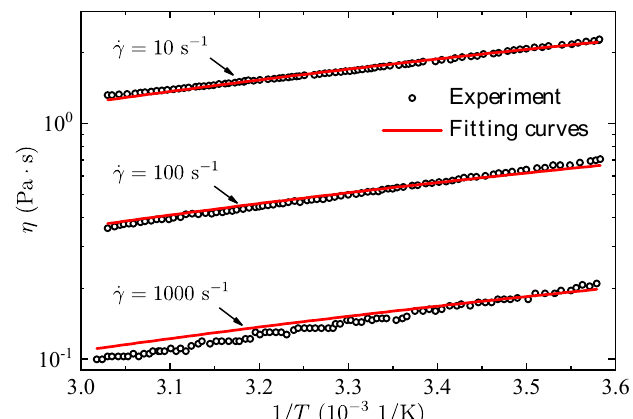
Figure 1. Experimental measurements and the model prediction of the viscosity of the water-gel. The experimental data is from [44]. The fitted parameters of Equation (8) are K = 167.7978 Pa · s n , n = 0.4751, a = − 1.116 × 10 − 2 1/K.